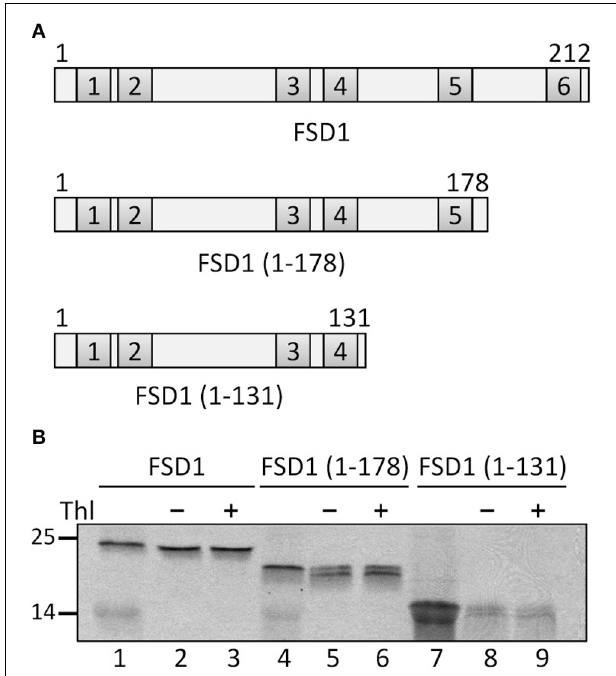
FIGURE 11 | The fifth recognition motif in the C-proximal end of FSD1 import is essential for binding and import. (A) Schematic representation of the constructs used for import in (B). (B) In vitro import assays of C-terminal truncations are depicted. Lane 1 shows 10% of translation product. Thl ( + ) indicates thermolysin digestion after the import reaction (lanes 3, 6, 9). Numbers on the left indicate size markers in kDa. Representative results from n = 3 independent experiments are depicted.